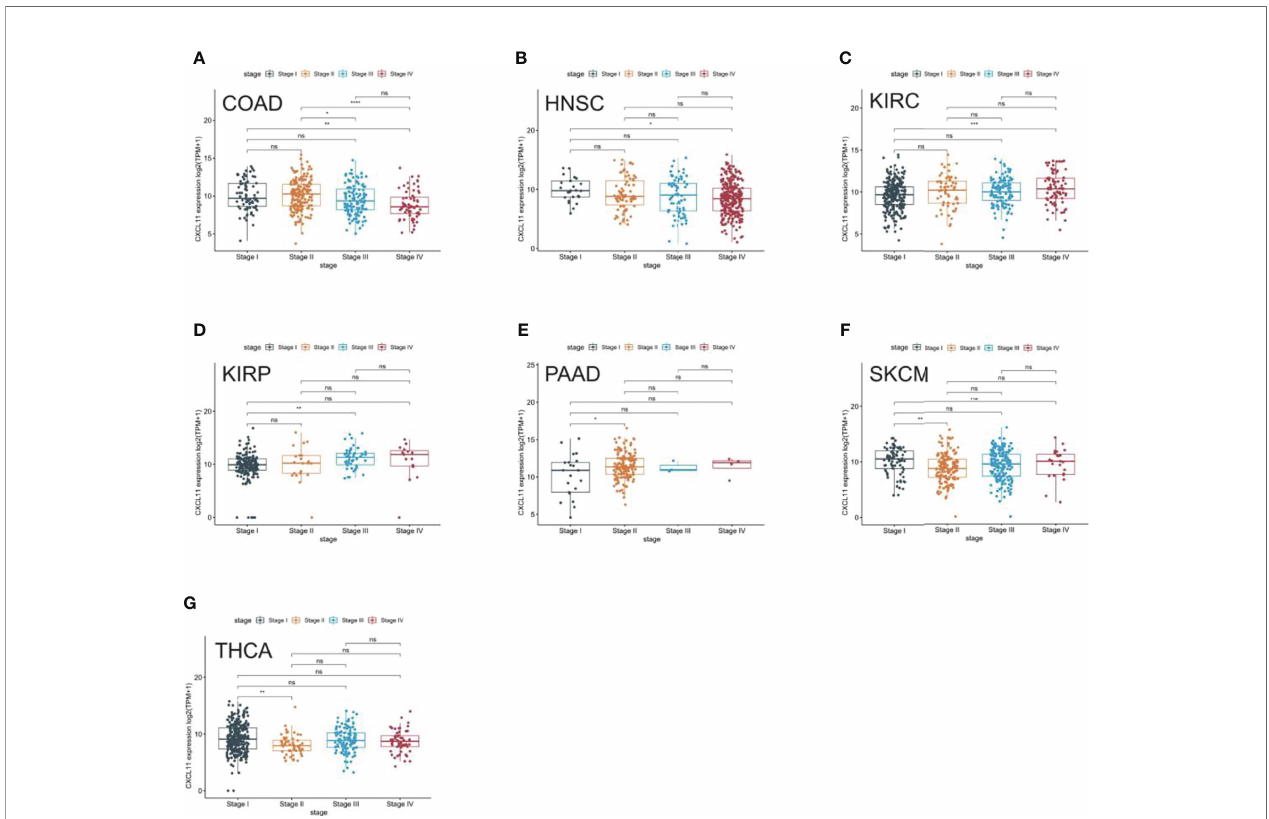
FIGURE 2 | Pan-cancer CXCL11 expression in different cancer stages. (A – G) Comparison of CXCL11 expression in different cancer stages de fi ned by the World Health Organization of different tumors in COAD, HNSC, KIRC, KIRP, PAAD, SKCM, and THCA. ns denotes not statistically signi fi cant, *p < 0.05, **p < 0.01, ***p <0.001, ****p <